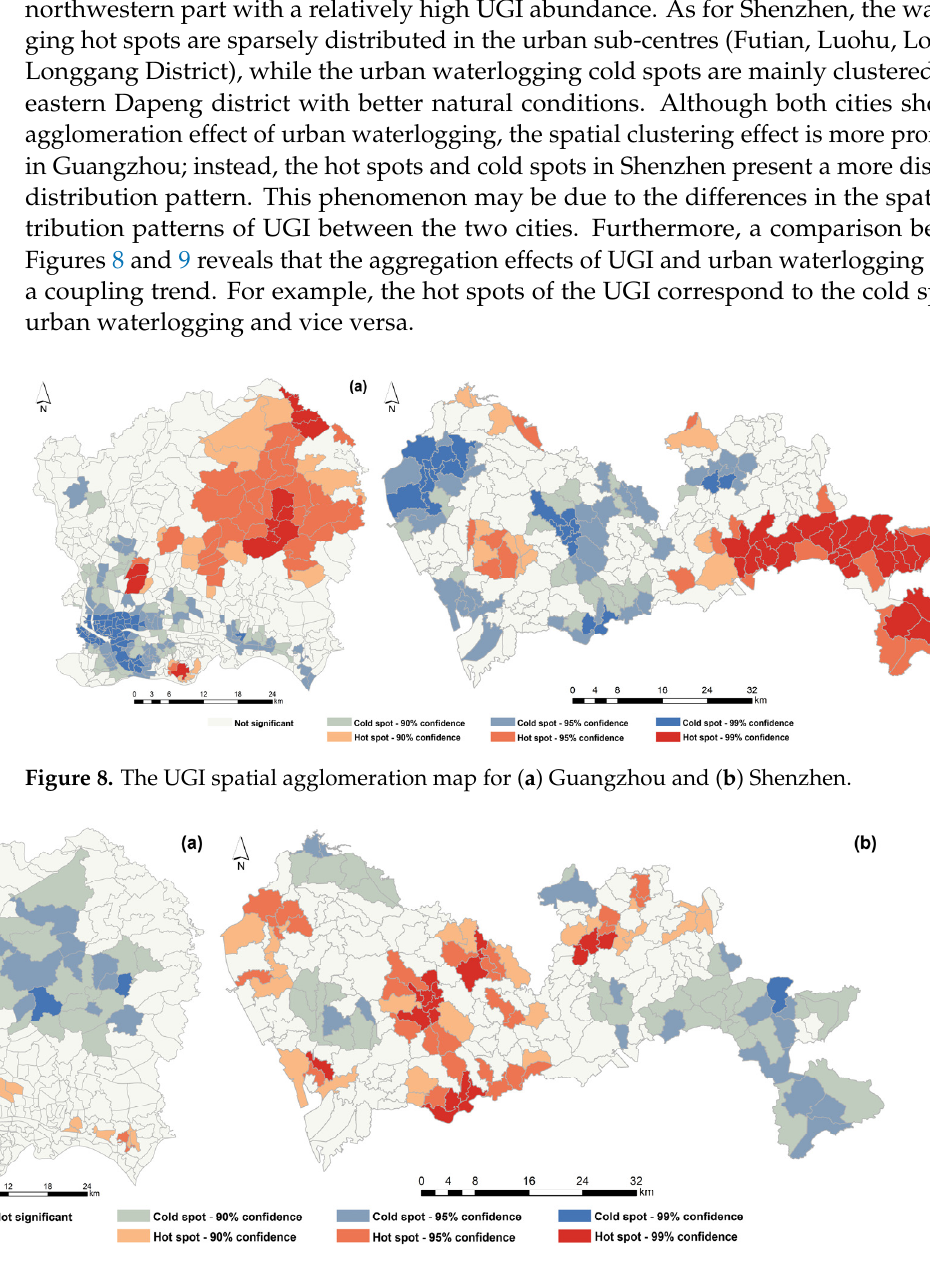
Figure 9. The waterlogging spatial agglomeration map for ( a ) Guangzhou and ( b )